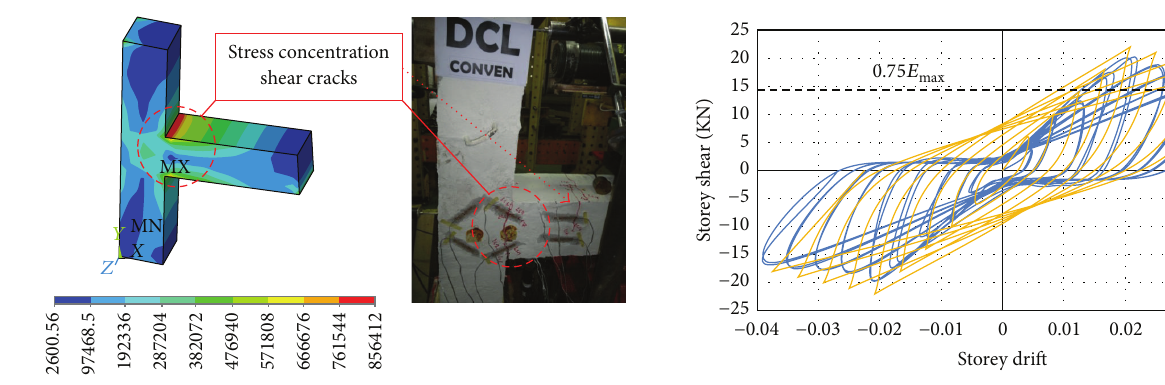
Figure 10: Stress intensity results and the damaged state at the end of the seismic test for the DCL-CONVEN specimen.